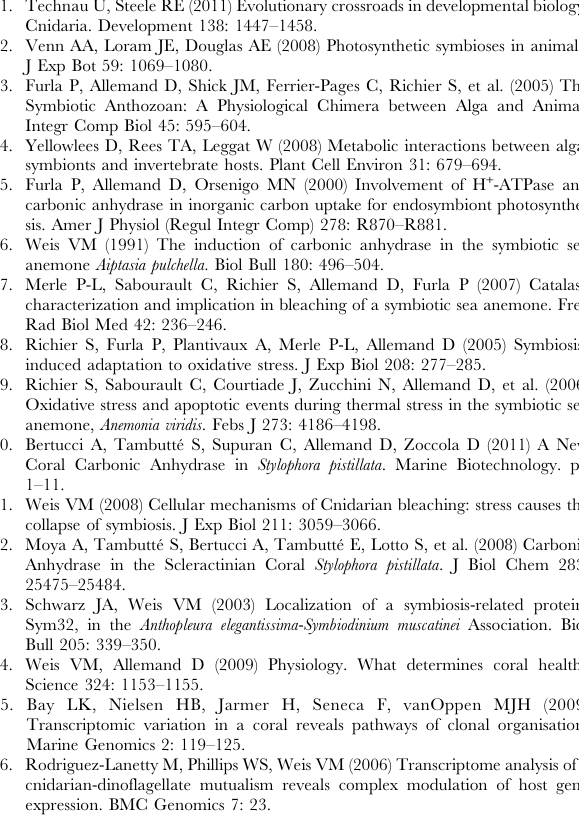
Figure S7 Phylogenetic analysis of the Sym32/Periostin/BGH3